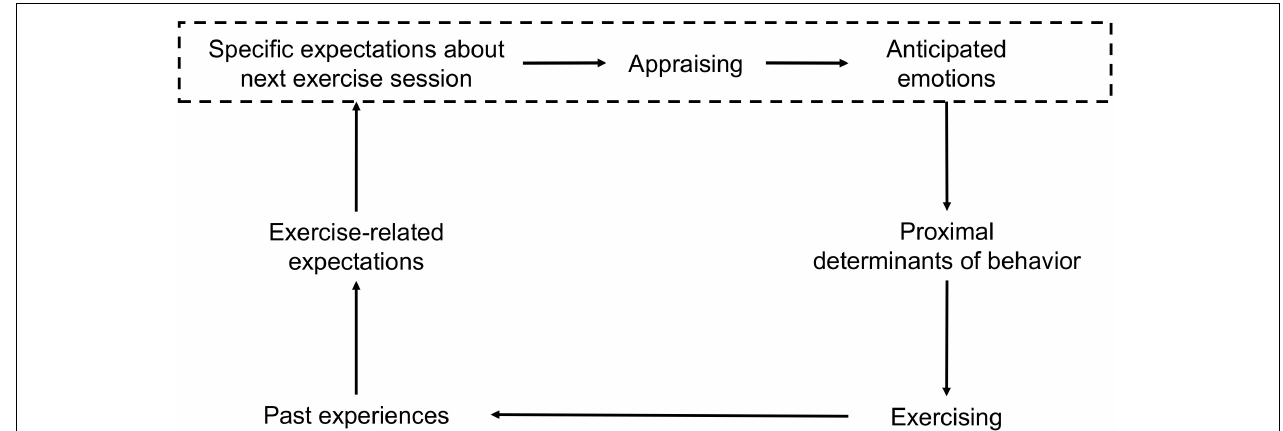
FIGURE 2 | Role of anticipated emotions in exercise